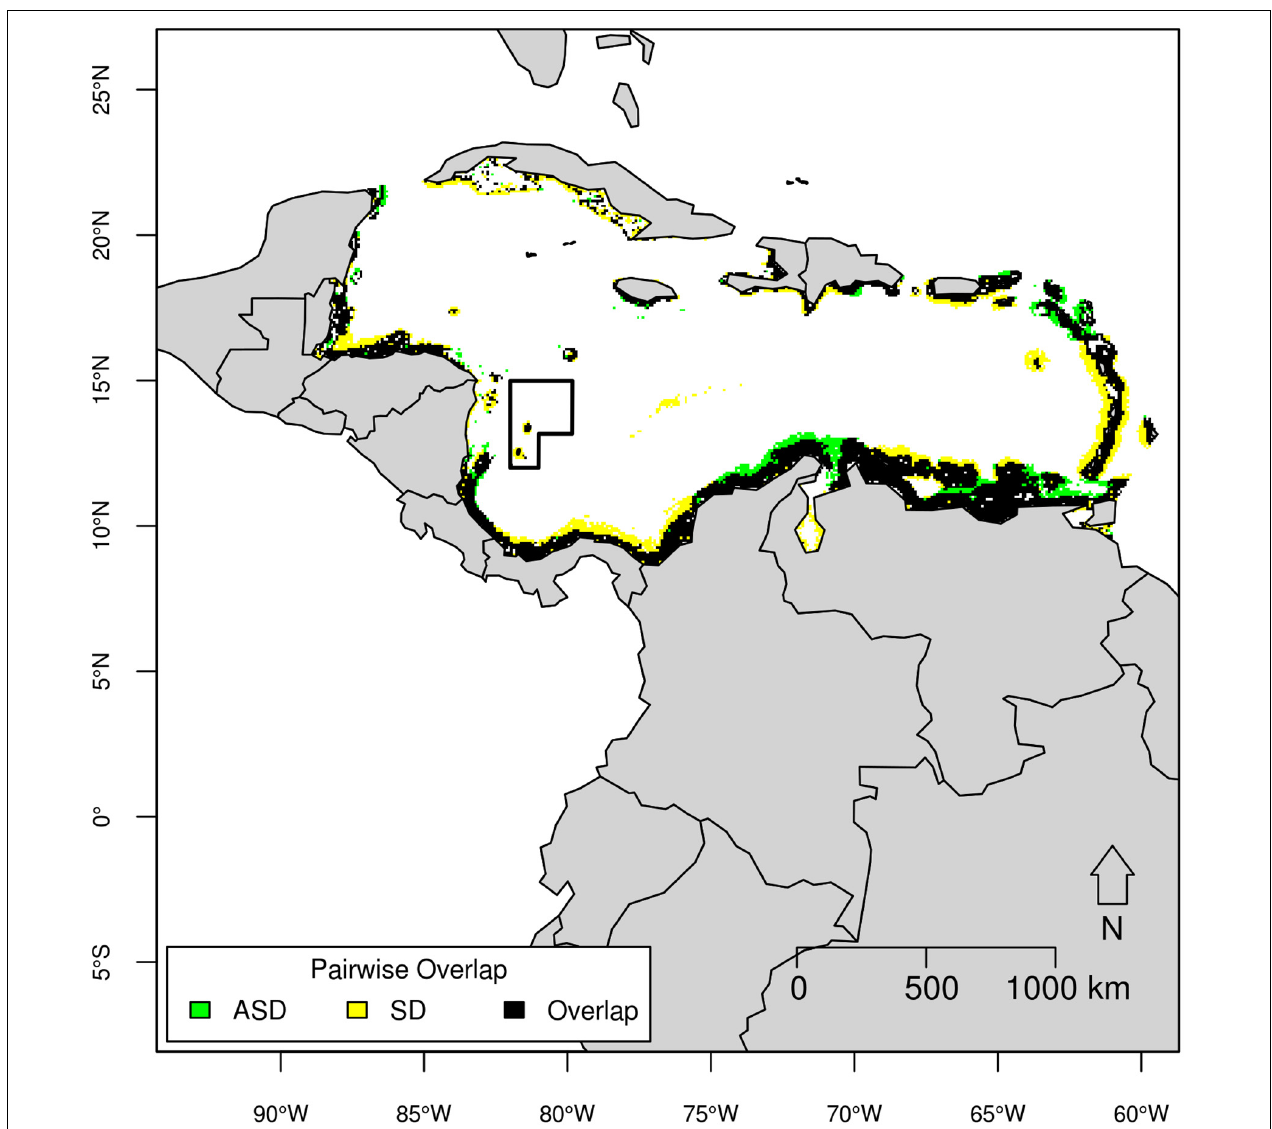
FIGURE 7 | Pairwise overlap map of Atlantic spotted dolphin (ASD) and spinner dolphin (SD) based on the threshold of equal test sensitivity and specificity.